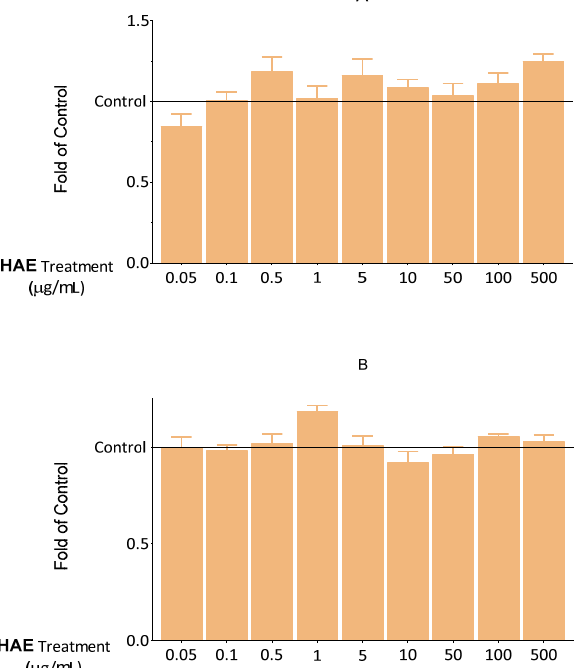
Figure 3. Viability of HUVECs was examined after 24 h using NRed. The results are expressed relative to the control (Control = 1; 0 µ g/mL HAE). Data are expressed as the mean ± SEM of four individual experiments. The thin grey solid line indicates the control level (Control = 1). Differences were considered statistically significant, when p < 0.05. We did not observe any statistically significant differences.